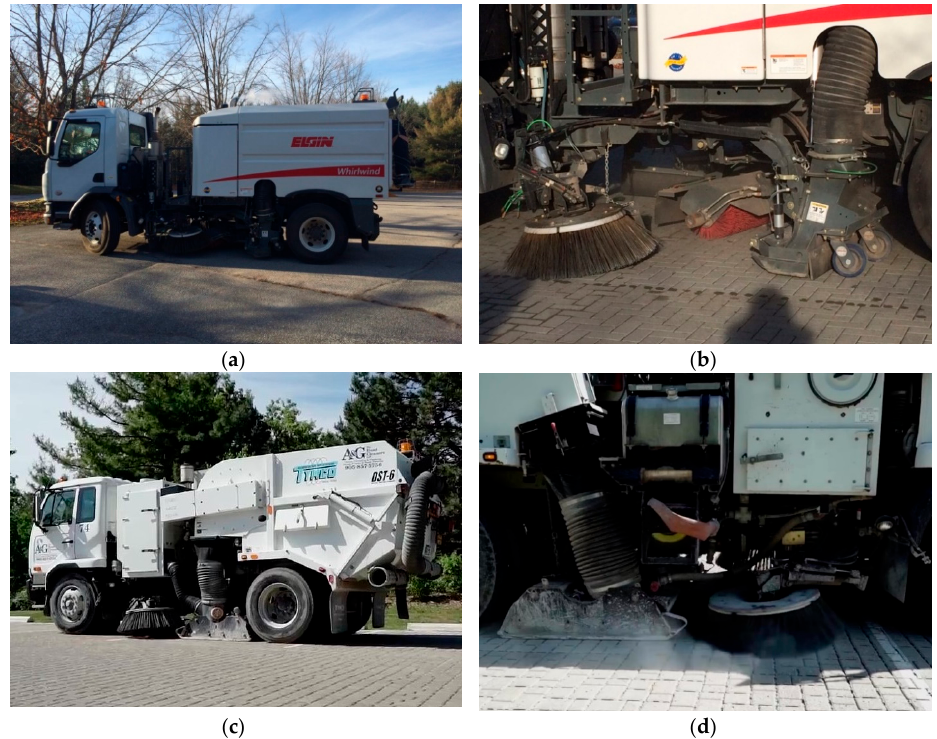
Figure 3 . Street sweeper ( a , b ) Elgin Whirlwind ® Vacuum Street Sweeper with cleaning head (top) ( c , d ) TYMCO DST-6 ® Regenerative Air Street Sweeper with cleaning head (bottom).